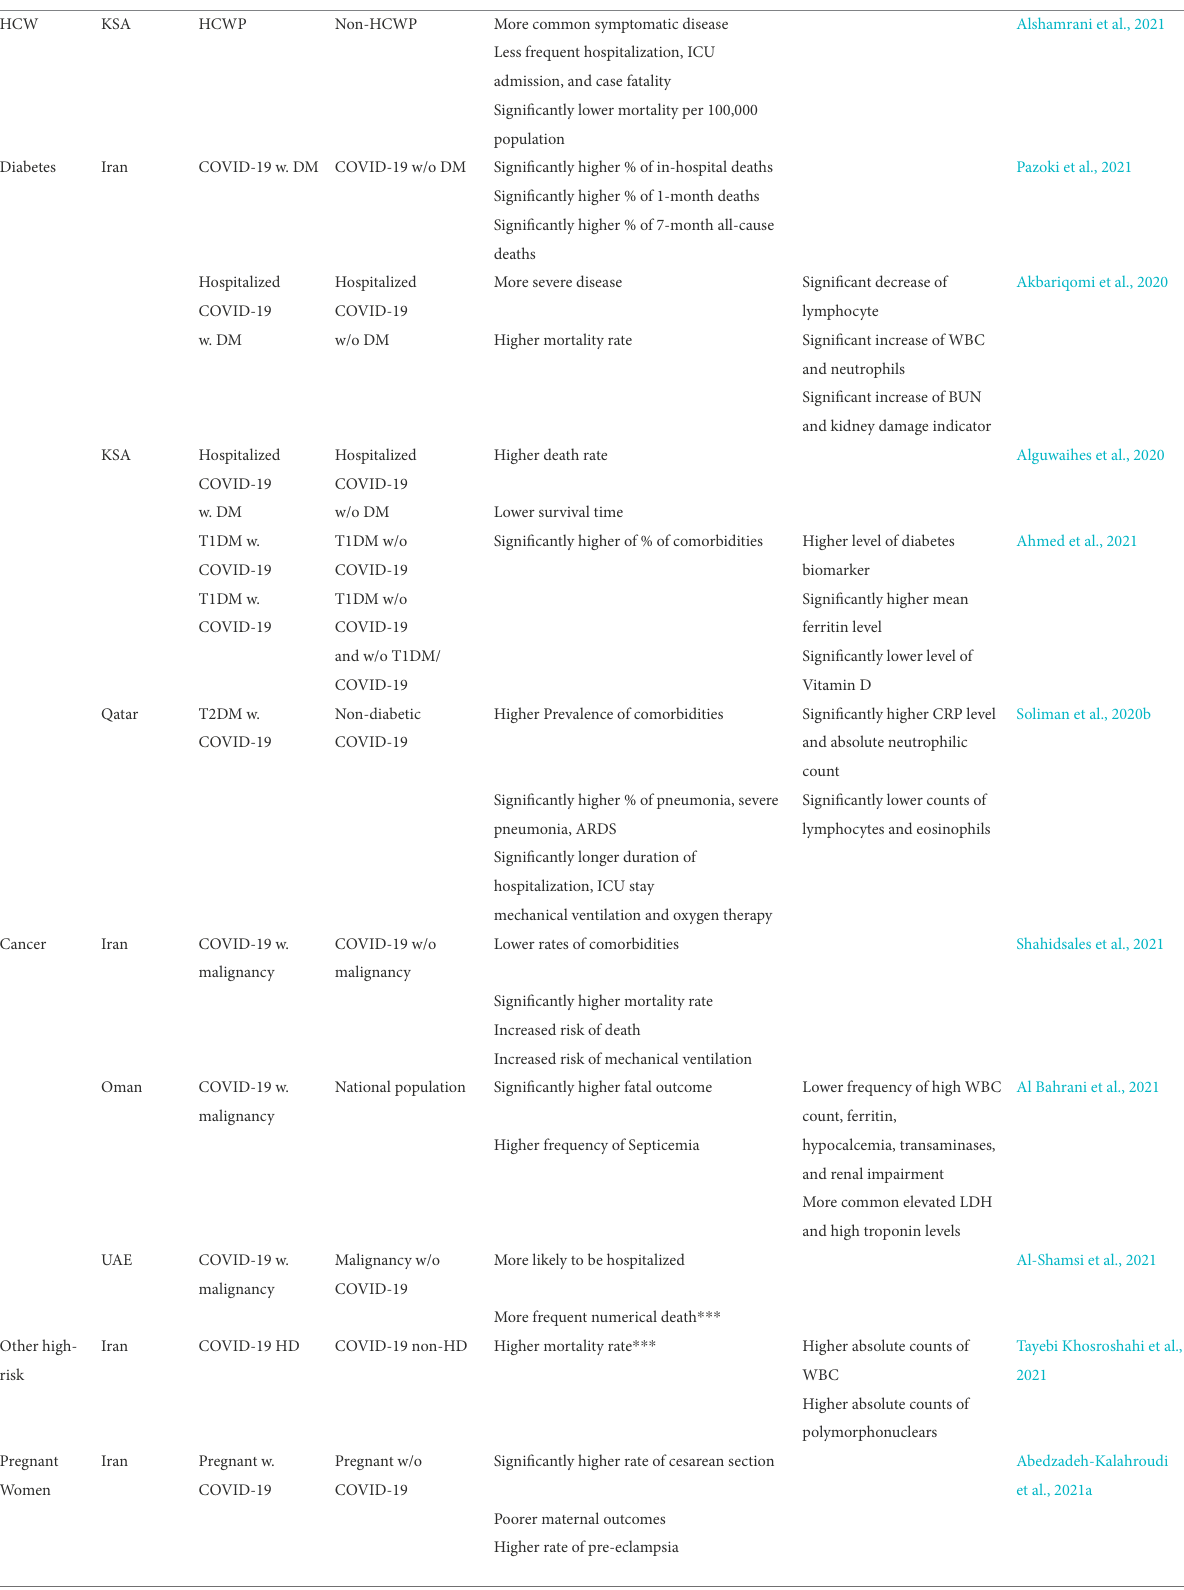
TABLE 1 Comparison of COVID-19 high-risk groups vs. healthy subjects in the Middle East. Category Country Study group Control group Clinical